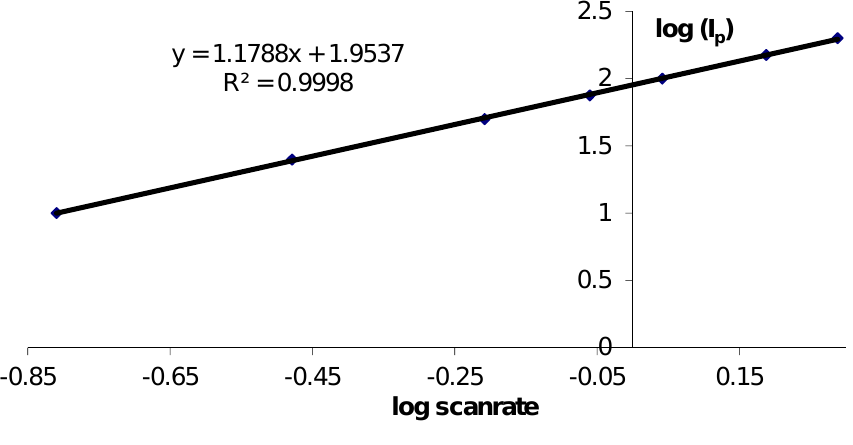
Figure 2. Logarithmic plot between the peak current I HHC|GelB|GC electrode.